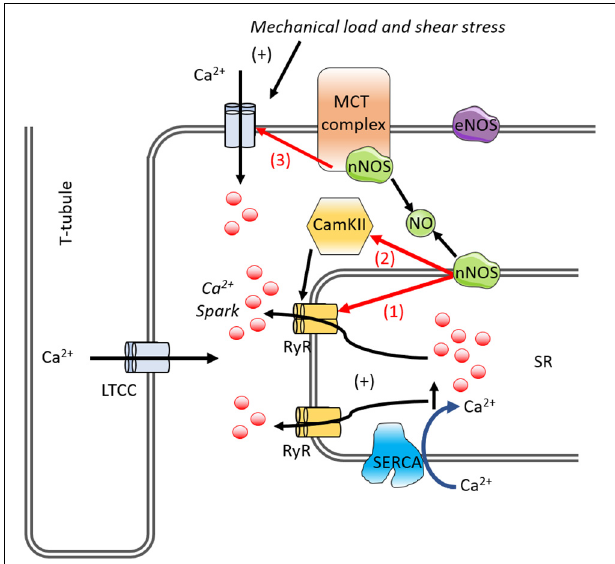
FIGURE 5 | A diagram of the mechano-chemo transduction pathways in the cardiomyocyte. Mechano-transduction involves NO for RyR activation. In cardiomyocytes, mechanical load, and shear stress causes Ca 2 + influx, Ca 2 + binds to and activates the underlying RyR. This increases spontaneous Ca 2 + spark via RyR. nNOS and CaMKII is activated promoting SR Ca 2 + leak via RyR phosphorylation. nNOS increases RyR Ca 2 + leak either (1) directly via S-nitrosylation or (2) indirectly via CaMKII. The (3) LTCC channel is affected by NO, inhibiting the channel. LTCC, L-type calcium current; NO, nitric oxide; nNOS, neuronal nitric oxide synthase; RyR, ryanodine receptor; SERCA, SR Ca 2 + -ATPase; SR, sarcoplasmic reticulum; CaMKII, Ca 2 + -calmodulin-dependent protein kinase